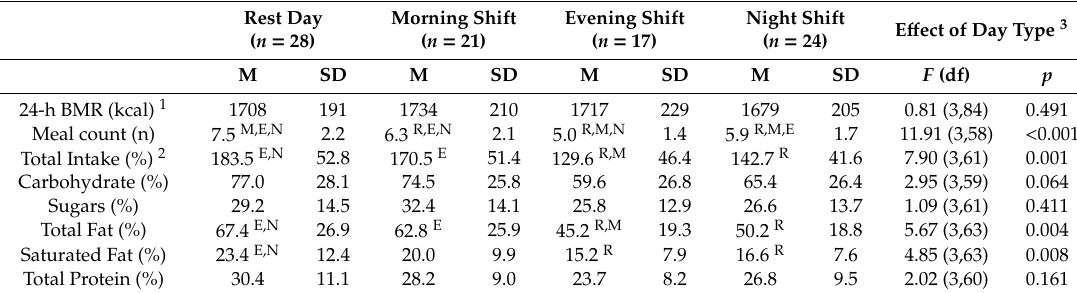
Table 2. Estimated basal metabolic rate (BMR), meal count, and total overall and macronutrient caloric intake expressed as percentages of BMR across each day type.